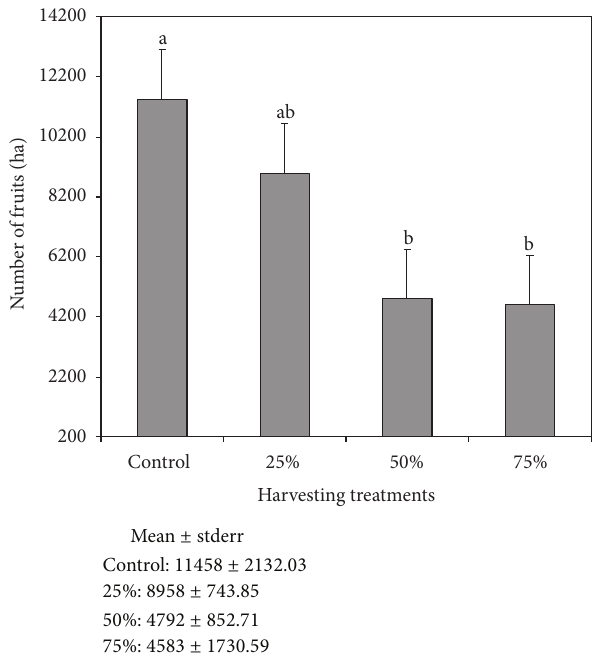
Figure 2: Effect of foliage harvest intensity on total fruit number of T. daniellii in the humid tropical rainforest zone of Ghana.